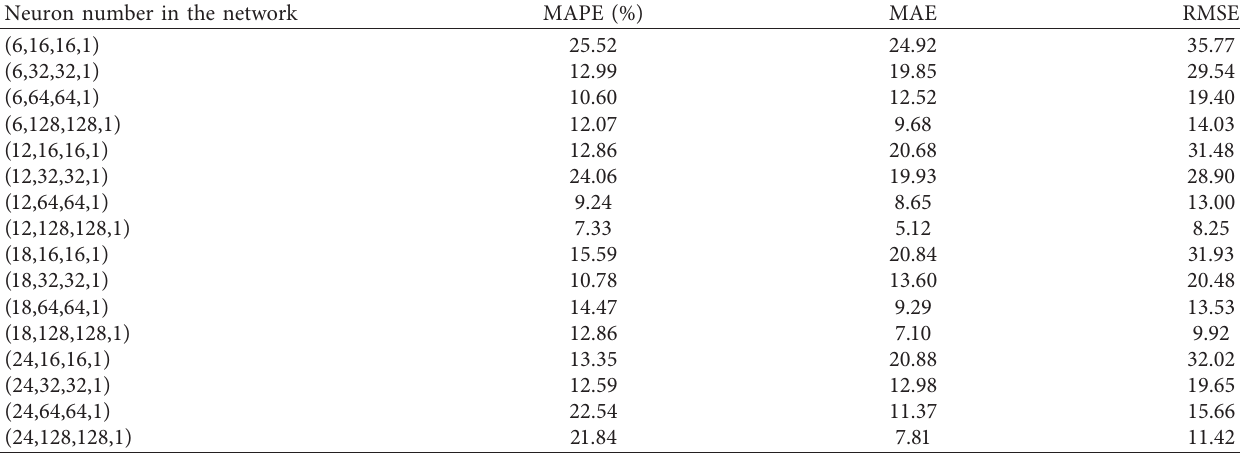
Table 2: Evaluation indicator results under different neuron numbers of input and LSTM layer. Neuron number in the network MAPE (%)